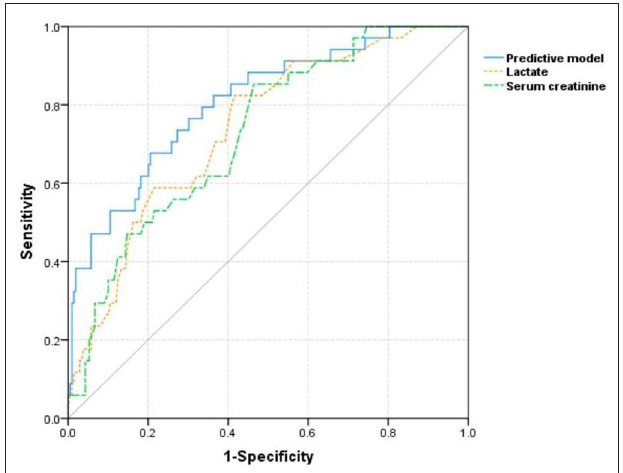
FIGURE 3 | The receiver operating characteristic curves of single lactate and constructed model for predicting acute kidney injury in included patients with